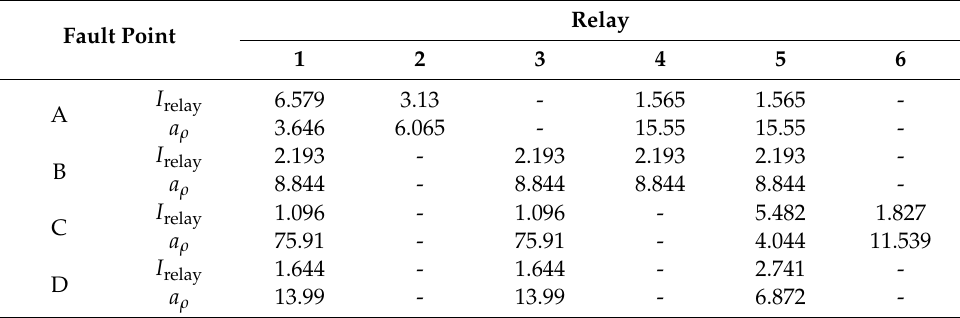
Table 7. a ρ constants and relay currents for Case